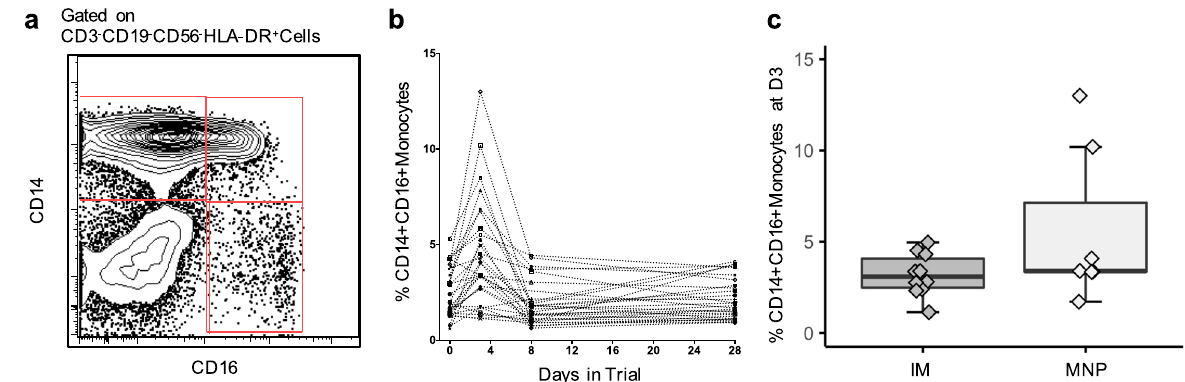
Fig. 5 CD14 + CD16 + monocytes after vaccination. a Monocytes were identi fi ed within the SSC-A-hi FSC-A-hi cells as the CD3-CD19-CD20- CD56- HLA-DR + population and gated for the CD14 + CD16-, CD14 + CD16 + , and CD14dimCD16 ++ subsets. b Temporal CD14 + CD16 + monocytes frequency over CD3-CD19-CD56-HLA-DR + cells at baseline, 2 – 3, 8, and 28 days post vaccination. c Percentage of CD14 + CD16 + monocytes at Days 2 – 3 on CD3-CD19-CD56-HLA-DR + cells by vaccine delivery group (MNP: n = 7; IM: n = 10). The box portion of the plot represents the interquartile range (IQR: 25th percentile, median, and 75th percentile) of the data. Error bars represent smallest and largest values within 1.5 times IQR. IM, IIV by intramuscular route; MNP, IIV by microneedle